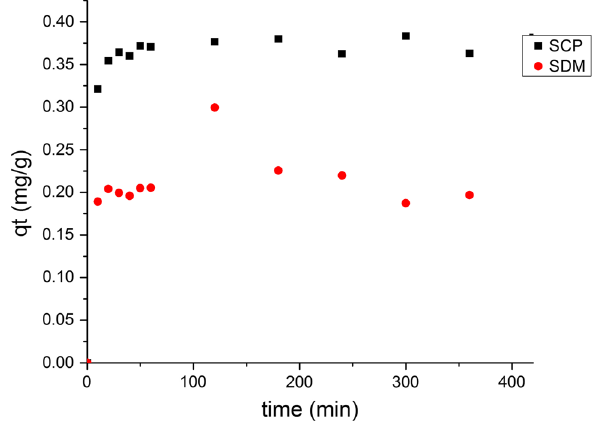
Fig. 3 Variation of adsorption capacity for SCP and SDM with time ( m = 0.1 g/50 mL, C i = 1 ppm, pH =